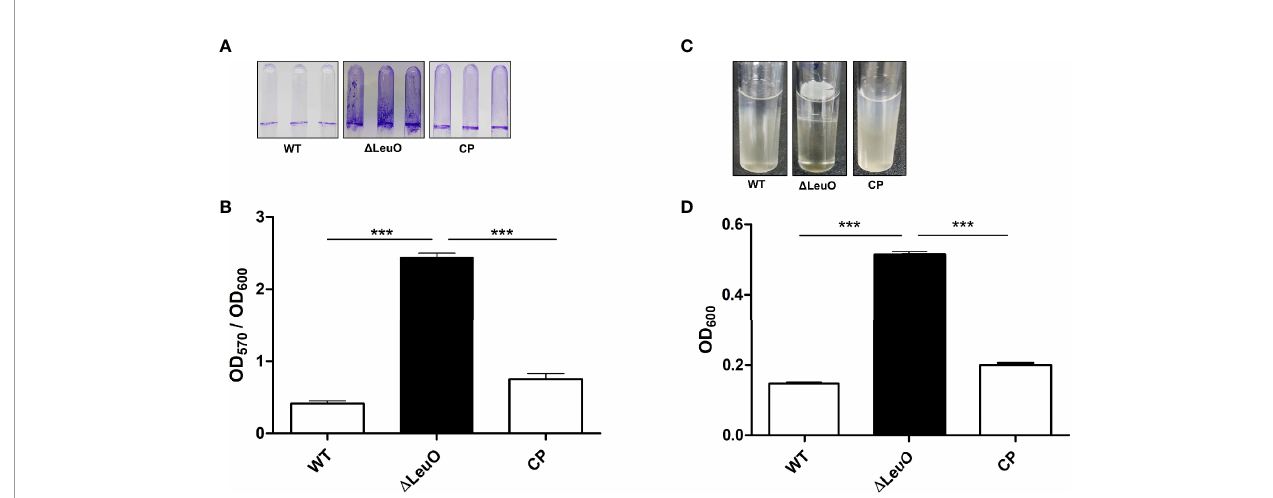
FIGURE 3 | Bio fi lm and air – liquid interface pellicle formed by A. baumannii 17978 WT, D LeuO, and complementation strains. A. baumannii ATCC 17978 WT, D LeuO, and its CP strains were cultured in 5-ml polystyrene tubes at 30°C for 24 h in LB broth without salt. (A) Bio fi lm formation on polystyrene tubes was photographed after staining with 0.1% crystal violet. (B) Bio fi lm values (OD 570 ) were normalized by growth levels (OD 600 ) to compensate for the levels of bio fi lm formation on the polystyrene surface. Bio fi lm formation assays were conducted in triplicate, and average values of three replicates were plotted with standard deviation. (C) A. baumannii strains were cultured at 30°C for 48 h in LB broth without salt, and the pellicle formed by each strain was photographed. (D) Pellicles were separated by adding methanol, and pellicle biomass was measured as OD 600 . This experiment was performed in triplicate. Data are expressed as average values of three replicates with standard deviation. ***P < 0.001, signi fi cantly higher than that of the wild-type